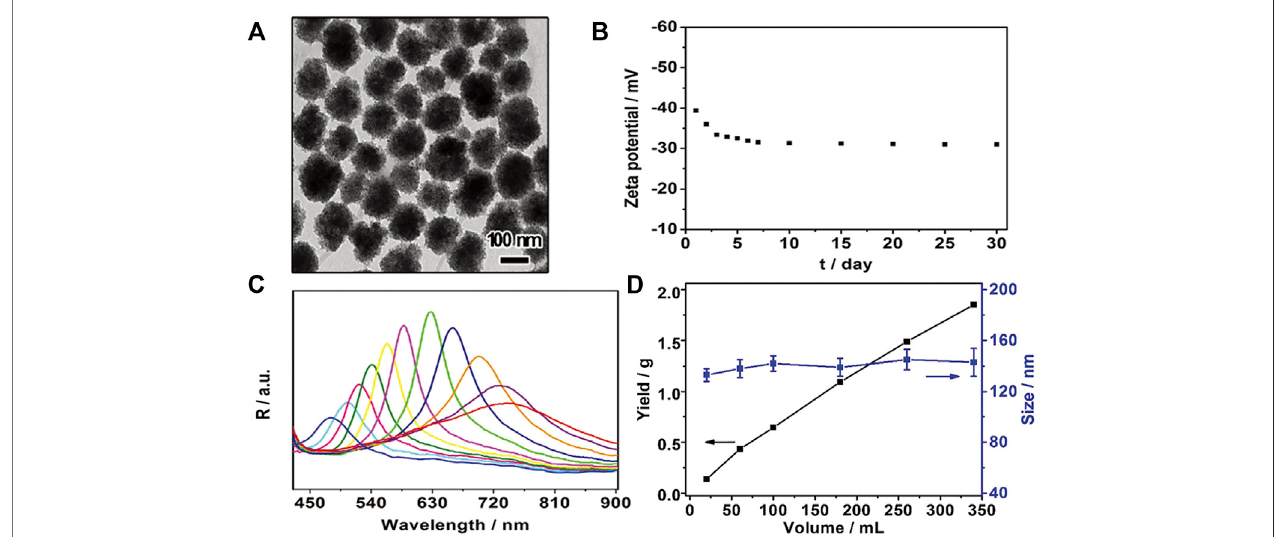
sample – magnetdistancefrom7to3 cmwithastepof0.5 cm;and (D) ThemassyieldandparticlesizeofFe 3 O 4 CNCsobtainedbyhydrothermalreactionswithdifferent amounts of EG. Reprinted with permission from Yang et al. (2016). Copyright © 2016 Royal Society of Chemistry.